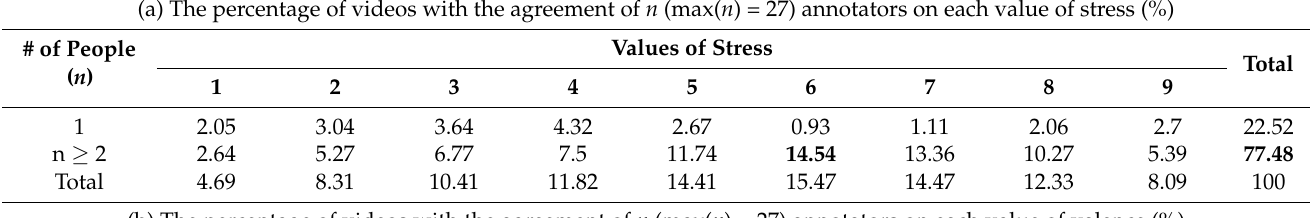
Values of Valence lowest to highest have been shown clearly by color scales. The results showed that 77.48% of videos agree with two annotators and more for all levels of stress, 78.6% of valence, and 78.94% of arousal. As it is shown, the highest percentage of videos with two or more annotators’ agreement is on level four on valence (17.83%), and six on stress (14.54%) and arousal (15.16%); while the lowest percentage of videos with two or more annotators’ Values of Arousal agreement is on level nine of valence (1.09%), on level one of stress (2.64%), and arousal (1.95%). Visual inspection shows that some of the videos are likely to be understood differently and can be labeled with different levels of stress, valence, and arousal. For example, Figure 4 shows the number of people who annotated the given video with various levels of stress, valence, and arousal.